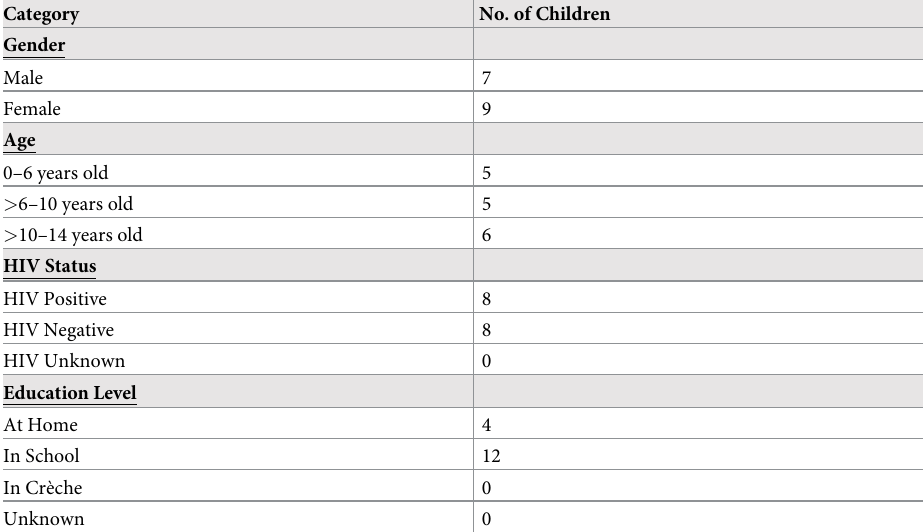
Table 1. Demographics of the 16 children that participated in this